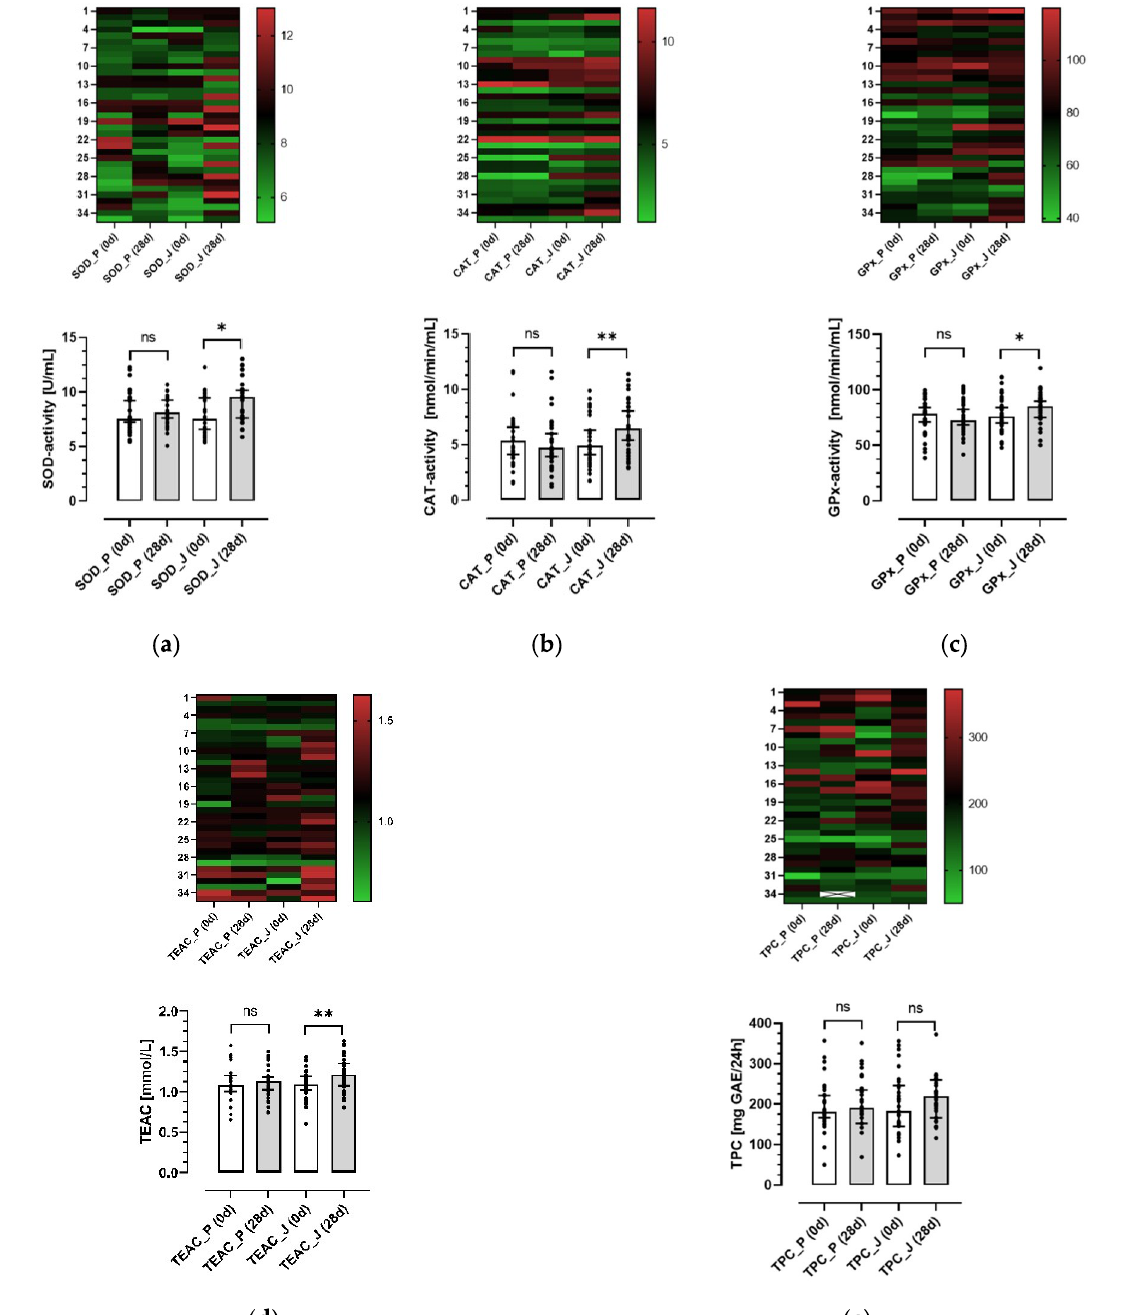
Figure 4. Effects of the anthocyanin-rich juice and the anthocyanin-depleted placebo on antioxidative parameters before and after intervention. Study participants consumed 0.33 L of the anthocyanin- depleted placebo (P) and anthocyanin-rich juice (J) over 28 days. Before (0 d) and after (28 d) intervention, blood samples were drawn and 24 h-urine samples were collected. Enzyme activities of SOD (U/mL) ( a ), CAT (nmol/min/mL) ( b ), GPx (nmol/min/mL) ( c ) as well as TEAC (mmol/mL) ( d ) were measured in plasma ( n = 35). TPC (mg GAE/24 h) ( e ) was measured in urine ( n = 34). Upper panel: Heatmap analyses showed single values for each participant. Lower panel: Values are presented as aligned dot blot bars with median and interquartile range (25th–75th). Significant differences were calculated with a mixed model with multiple comparison test (Š í d á k’s) or ANOVA with multiple comparison test (Š í d á k’s). Values after intervention were different with * p < 0.05, ** p < 0.005 to corresponding controls. ns, non